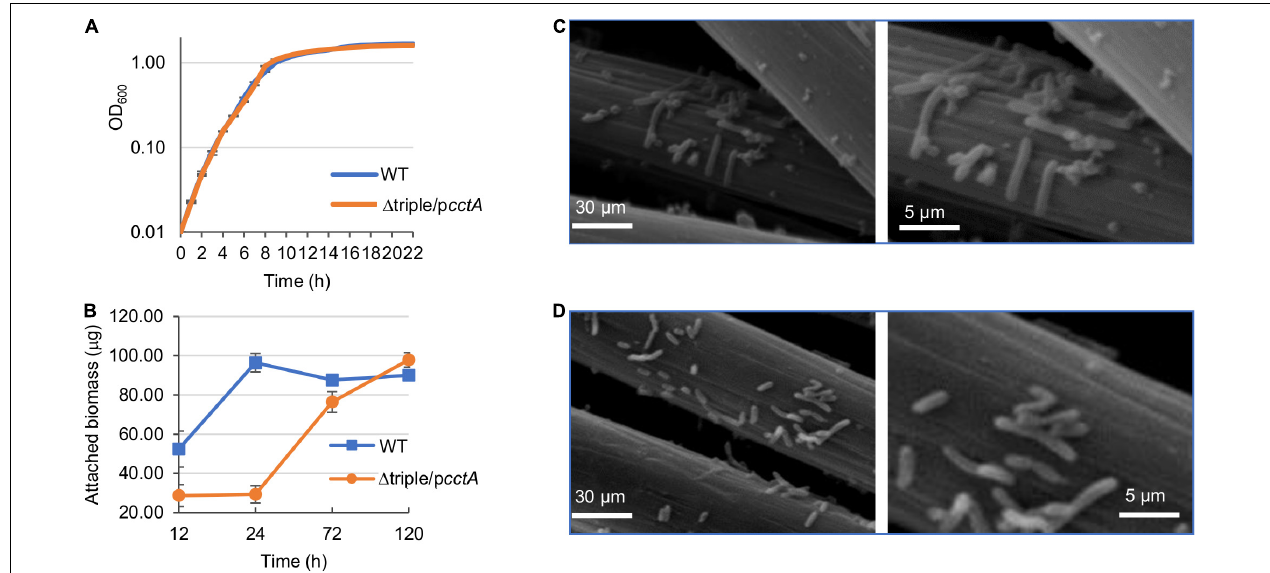
FIGURE 6 | Impacts of mutations with overexpressed CctA on growth and biofilm structure. (A) Growth of WT and (cid:49) triple/p cctA on TMAO. Cells growing exponentially were inoculated into the fresh MS with 30 mM TMAO as the EA. Growth was monitored by recording the optical density at 600 nm. (B) Biofilm mass of (cid:49) triple /p cctA and WT formed on the anode of MFC. At each time point, the total biomass of the biofilms grown on the anodes was determined by using bicinchoninic acid (BCA) measurement as described in the section “Materials and Methods.” (C,D) Characterization of the anodic biofilms of MFC after output voltage reaching the peak. SEM images of the biofilm of WT (C) and (cid:49) triple/p cctA (with induction of 0.5 mM IPTG) (D) . The right panels represent a portion of the images on the left panels enlarged. Three independent operations were performed with data presented in panels (A,B) by the means ± SD and representative images shown in panels (C,D)